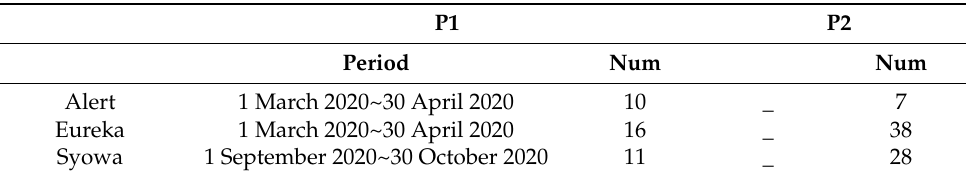
Table 3. The division set for the ozone hole (P1) and non-ozone hole period (P2) at Alert, Eureka, and Syowa stations; the ‘_’ symbol indicates the observation times in 2020, except for those already listed in P1.